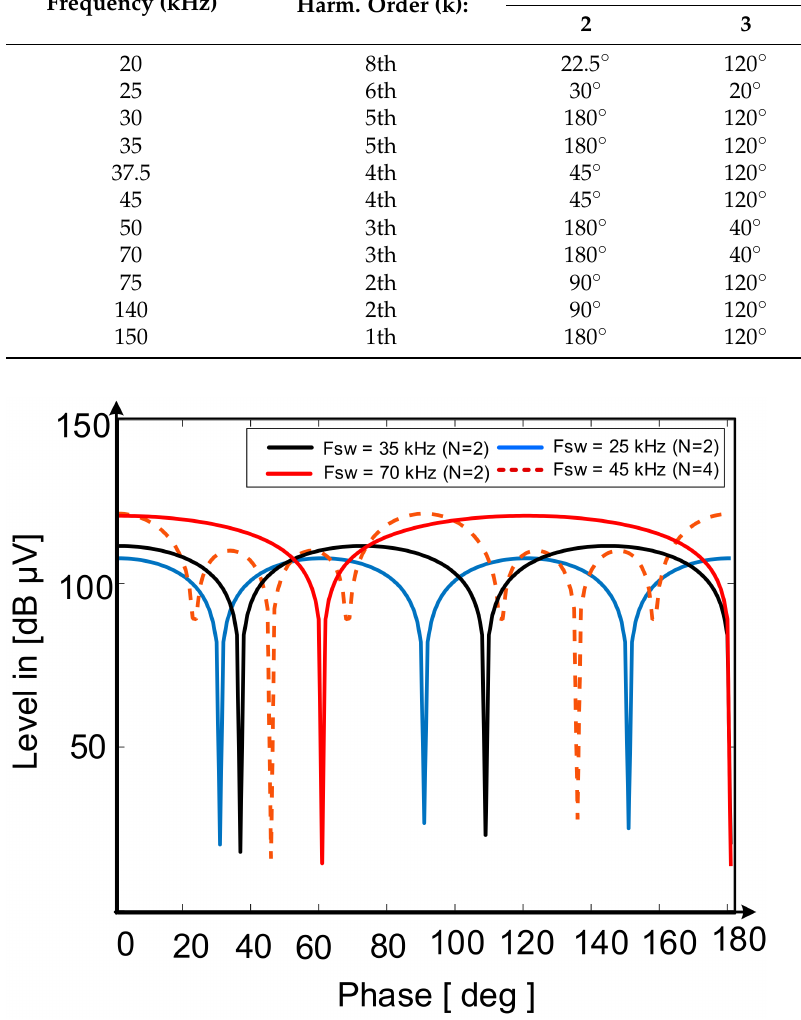
Figure 8. First carrier harmonics behavior with various switching frequencies in Band-B for three interleaved units with different